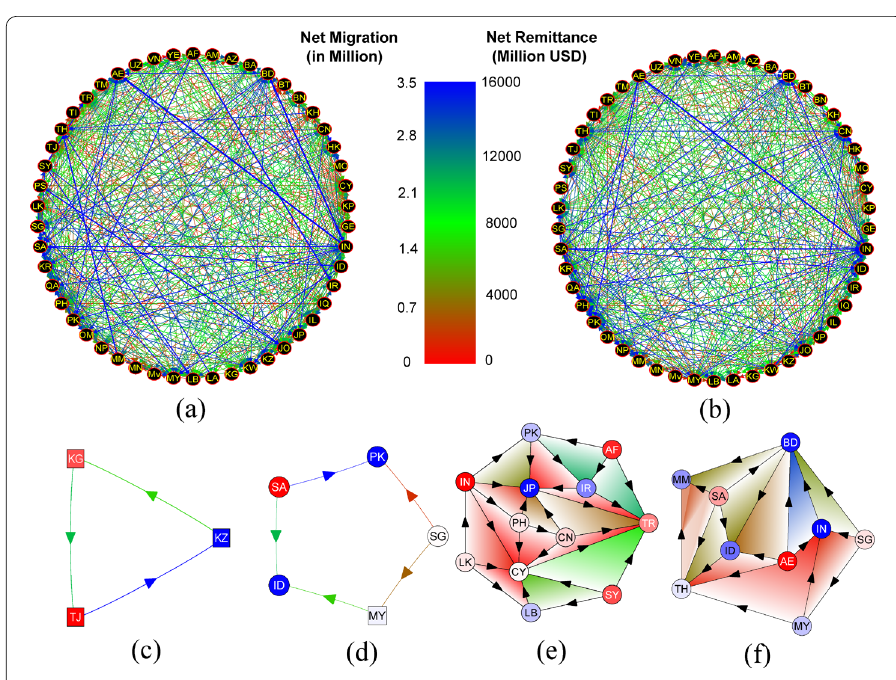
Figure 1 Asian net Migration and Remittance Networks. ( a ) Each edge in the Asian net migration network is weighed using a weight function similar to equation 1, and colored according to increasing weight from red to blue. Country abbreviations are as in Table 1. ( b ) The directed graph of the Asian net remittance network is constructed similarly. ( c ) A circular flow of migrant surplus between Tajikistan, Kazakhstan, and Kyrgyztan. ( d ) Net remittance flow among Indonesia, India, Malaysia, Saudi Arabia, and Singapore. ( e ) An example of a more complex flow of migrant surplus among groups of countries in Asia. Each triangle is colored according to flow magnitude, and graded with respect to flow direction. ( f ) An example of the complex flow of remittance surplus among groups of countries in